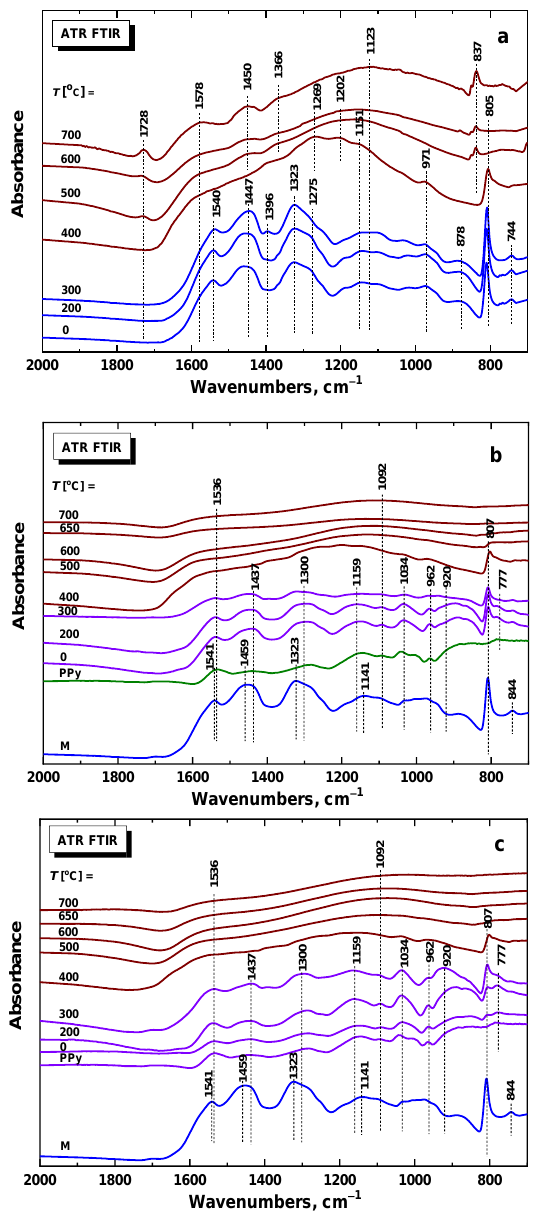
Figure 7. The evolution of the ATR FTIR spectra of ( a ) the melamine sponge (M), ( b ) the melamine sponge containing 8.2 wt%, and ( c ) 27.4 wt% polypyrrole, after exposure to various temperatures in inert atmosphere. Polypyrrole (PPy) spectrum is included for comparison. The groups of similar spectra are distinguished by colors.